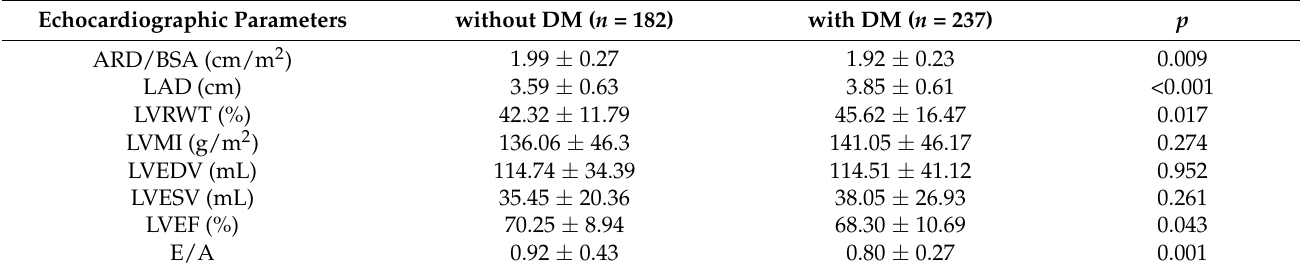
Abbreviations are the same as in Table